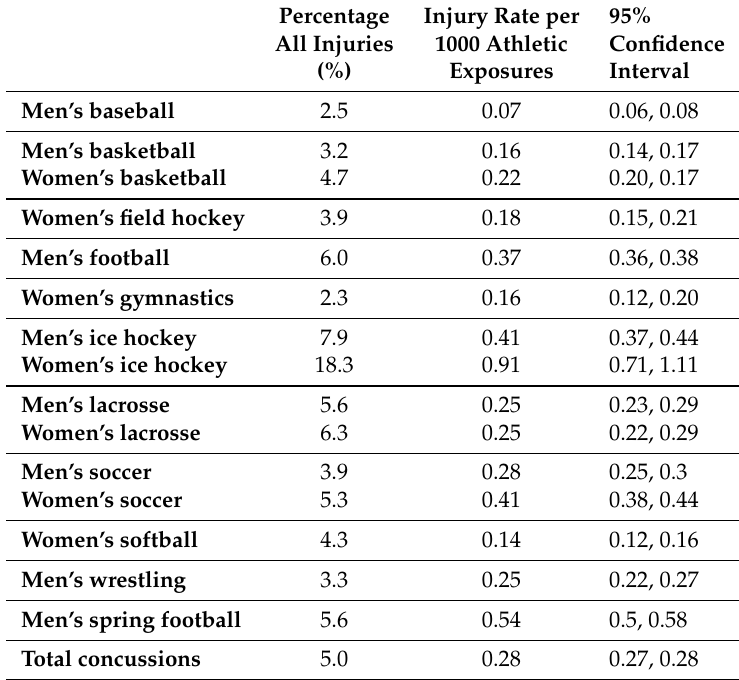
Table 2. Frequency, distribution, and rates of select injuries for games and practices combined